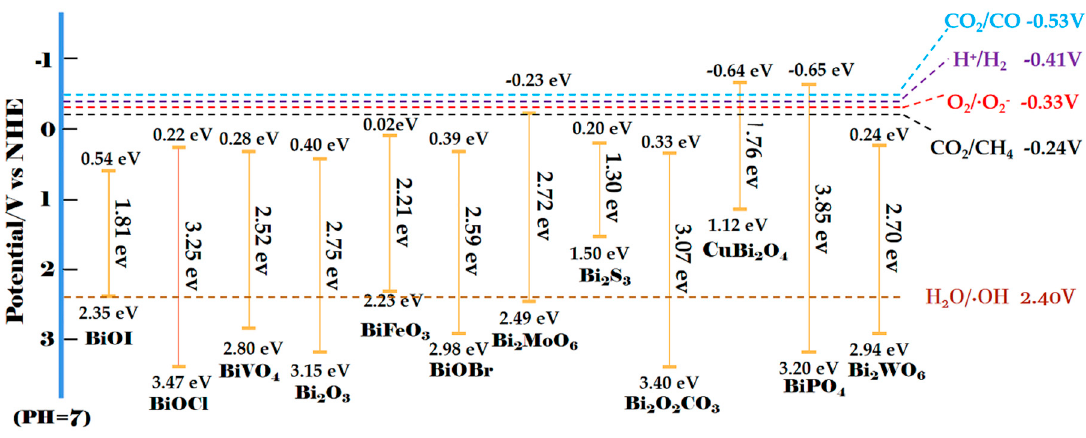
Figure 1. The bandgap structure of part of representative Bi-based semiconductors.